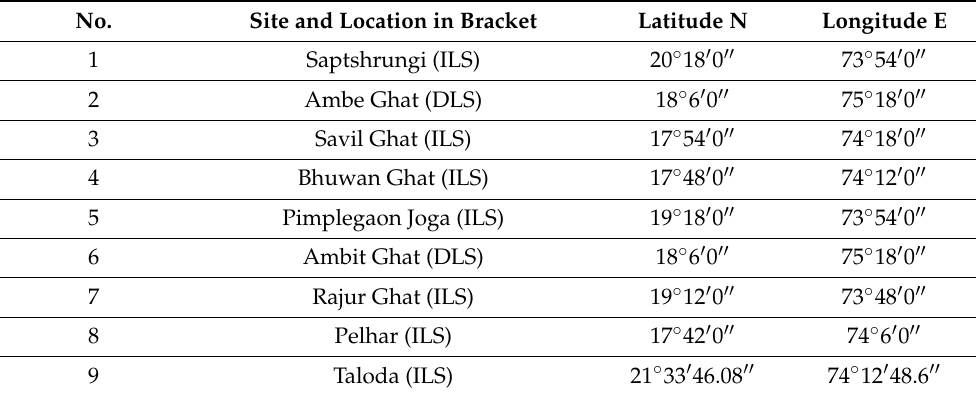
Table 2. Locations of LS-prone sites in the Nashik subregion. The words windward, ILS and DLS indicate the locations of LS sites on the windward, immediate leeward and distant leeward sites, of the WG mountains, respectively.